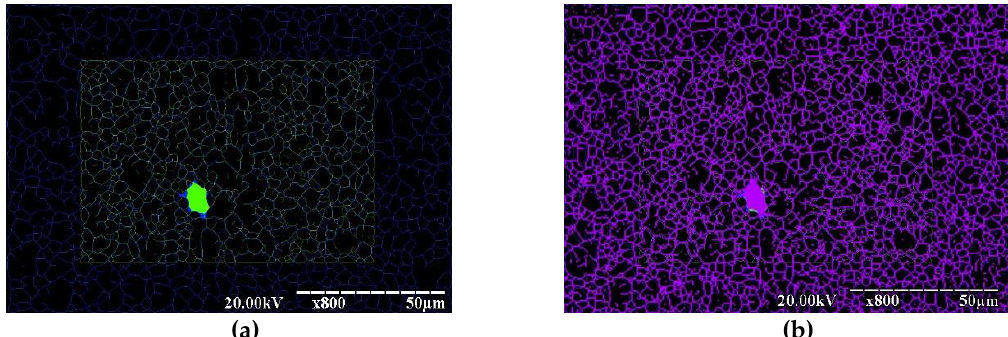
Figure 5. Graphical comparison of the network of dimples identified in fractograms with di ff erent magnification. Overlapping of dimple networks identified with magnifications x1200 and x800 ( a ); overlapping of dimple networks identified with magnifications x800 and x200 ( b ).